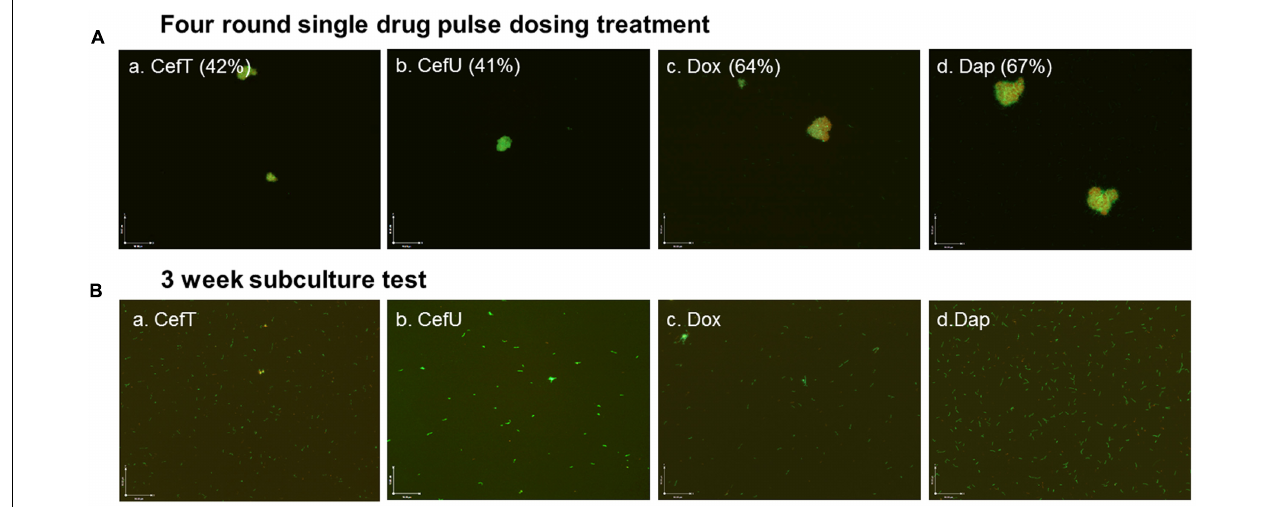
FIGURE 2 | Representative images of a 10 day old B. burgdorferi stationary phase culture treated with four rounds of pulse dosing treatment with different single drugs (Aa–d) and subcultured for 21 days in fresh BSK-H medium (Ba–d) . Stationary phase B. burgdorferi culture (10 day old) was treated with different single drug (5 µ g/ml) pulse dosing treatment as described in the section “Materials and Methods,” followed by staining by SYBR Green I/PI assay and fluorescence microscopy at 100 × magnification. The percentage of residual viable cells is shown in brackets. The percentage of residual viable cells was calculated according to the regression equation and green/red fluorescence ratios. None of the single drugs were able to eradicate the microcolony forms as shown by either SYBR Green I/PI staining or subculture studies. Abbreviations: CefT, ceftriaxone; CefU, cefuroxime; Dox, doxycycline; Dap,